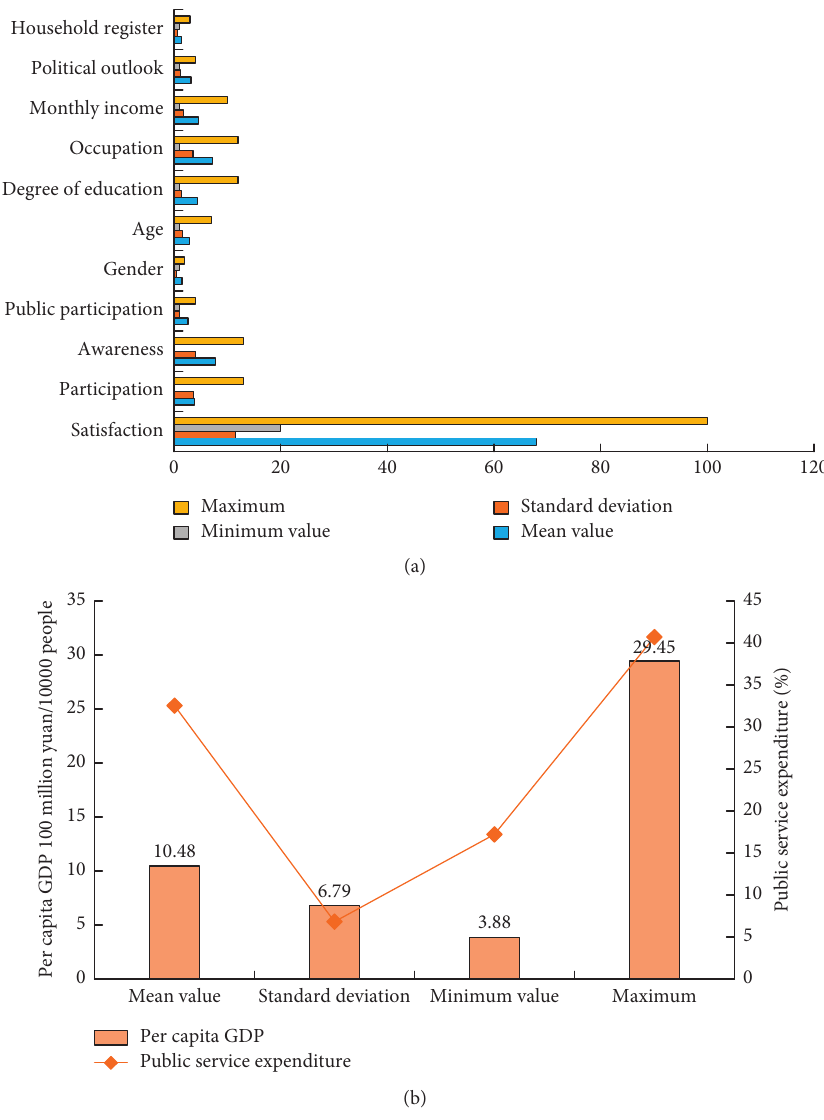
Figure 8: Subjective and objective variables. (a) Subjective variables. (b) Objective